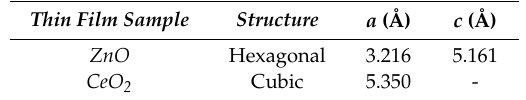
Figure 1. The X-ray diffraction (XRD) patterns of pure ZnO, pure CeO 2 and ZnO:CeO 2 mixed oxides thin films. Table 1. The structure and Lattice constants (a and c) for pure ZnO and pure CeO 2 thin